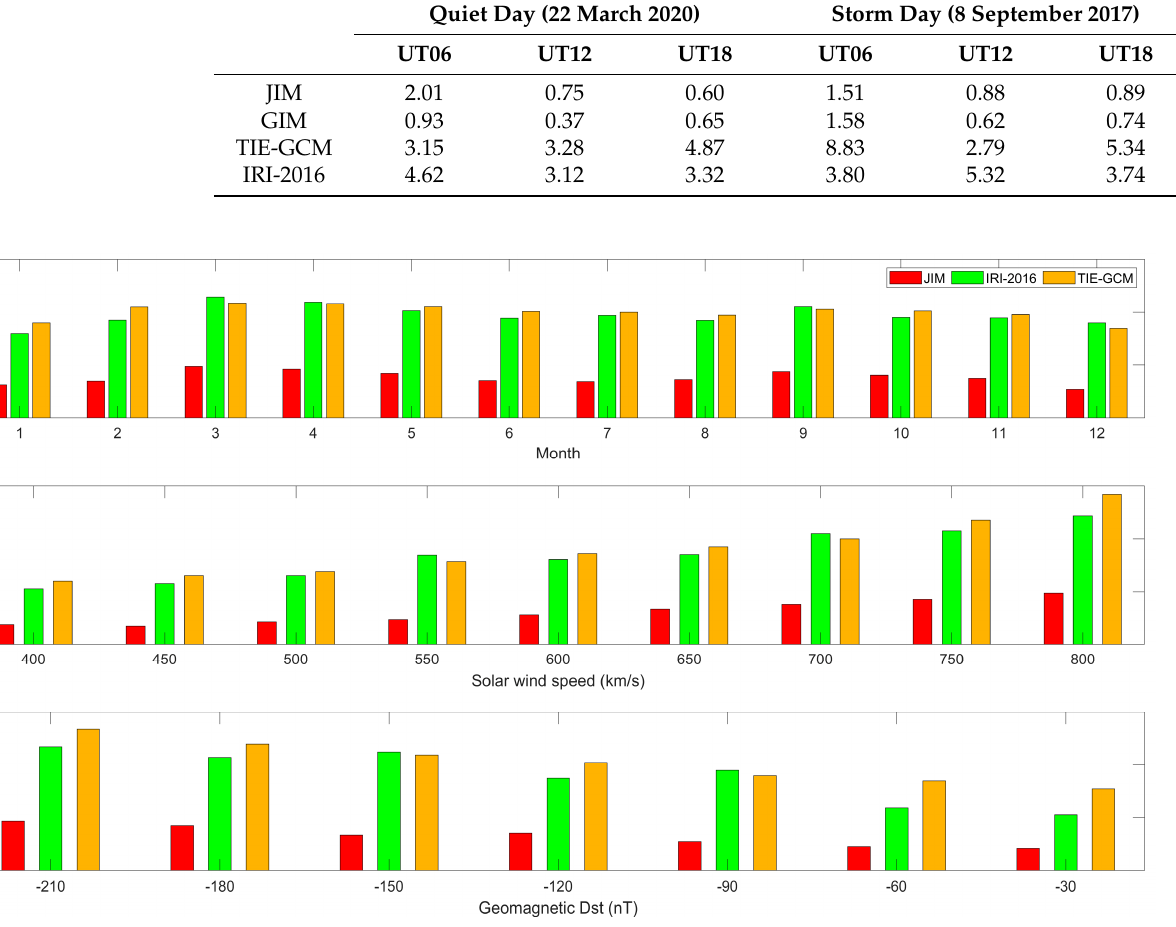
Figure 10. Root mean square errors (RMSEs) of TECs predicted by the JIM, IRI-2016 and TIE-GCM depend on months, solar wind speed (Vsw) and geomagnetic activity (Dst), respectively.